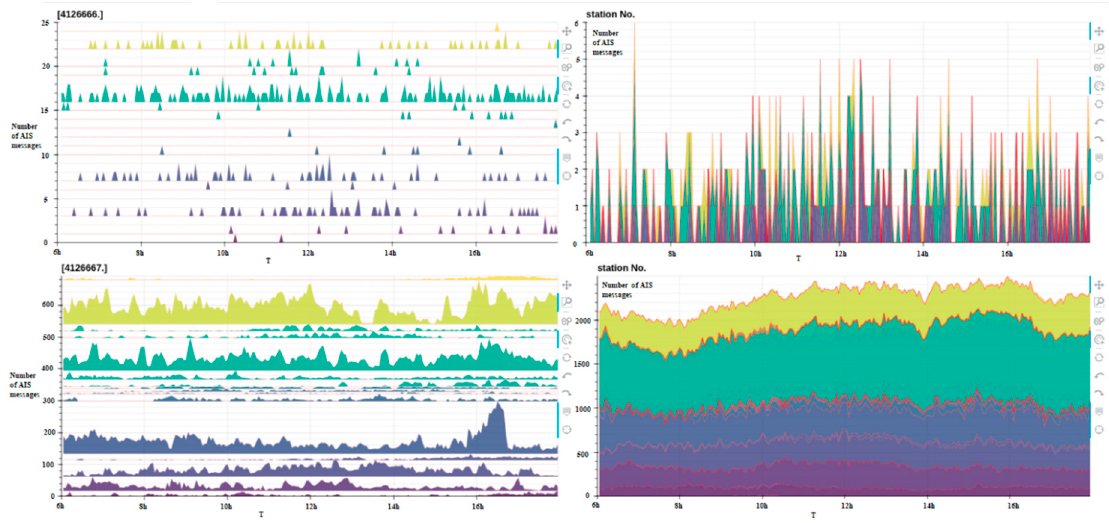
Figure 10. Interaction with a four quadrant stack graph.